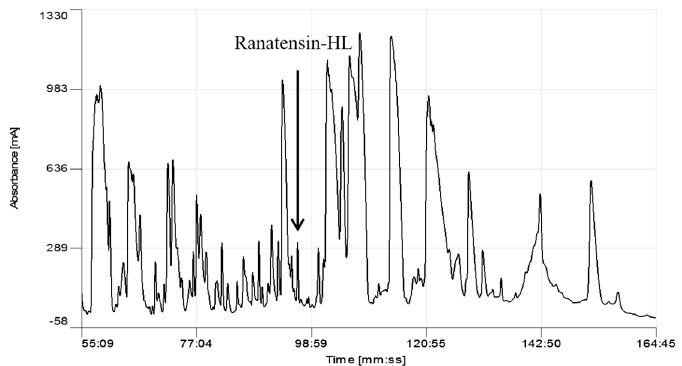
Figure 1. Region of reverse phase HPLC chromatogram of the skin secretion of Hylarana latouchii . The elution position/retention time of the pharmacologically-active peptide (ranatensin-HL), is indicated (arrow).